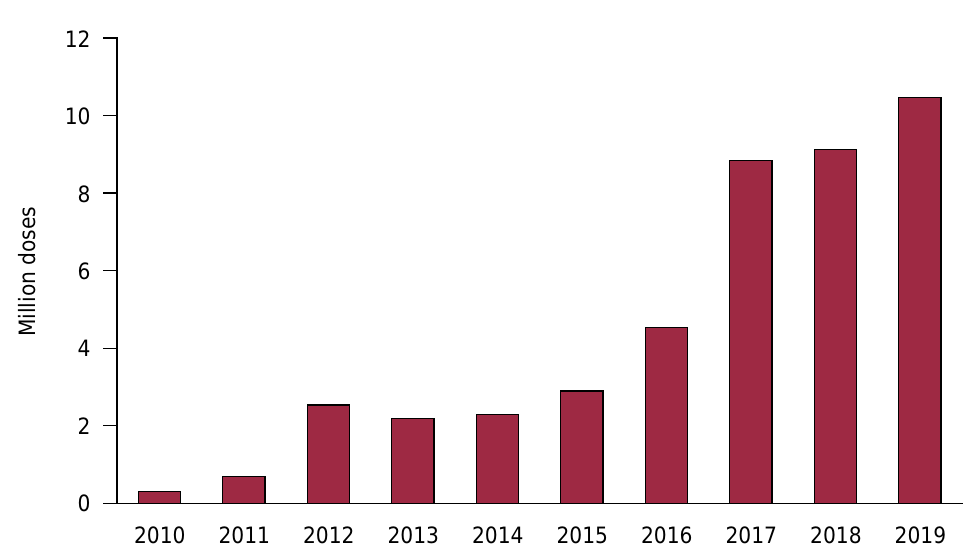
Figure 1. Doses of inoculants carrying Azospirillum brasilense strains Ab-V5 and Ab-V6 since the launch of the first commercial inoculant. Numbers based on data from Anpii (2020) and personal communication from the private